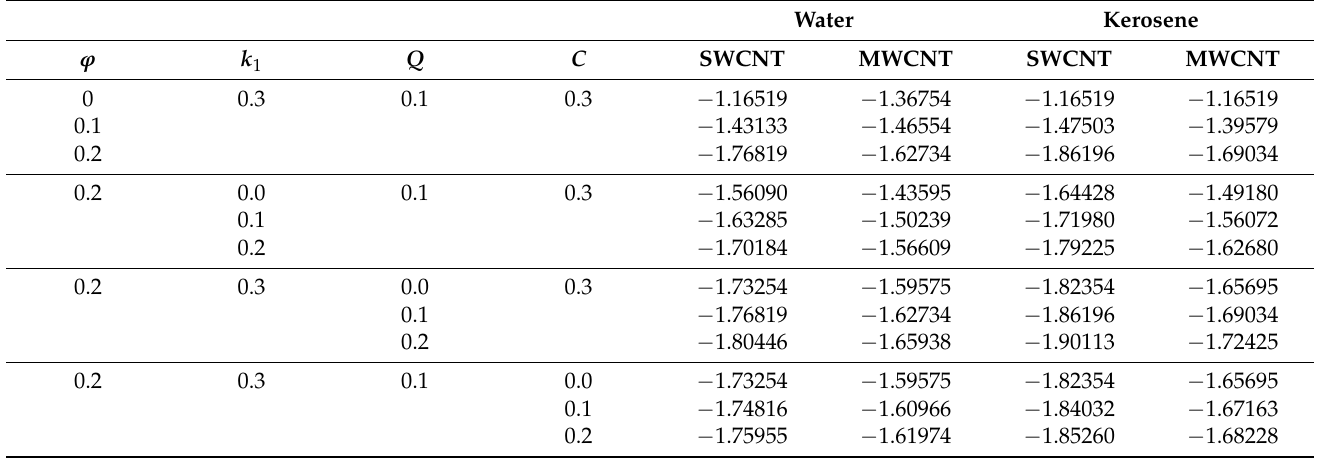
Table 2. Numerical values of various parameters for skin friction coefficient.